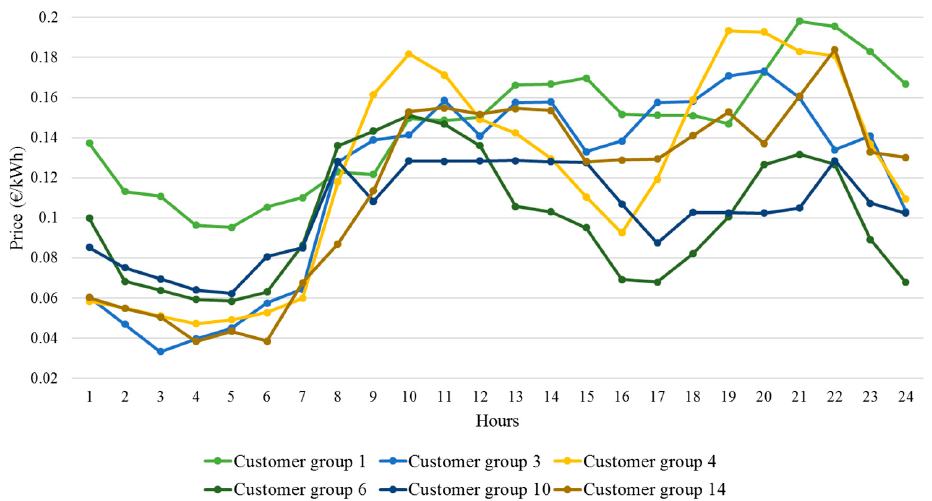
Figure 9. Retail rates for selected customers (Case 1). Table 6. Profit of the retail electricity provider (REP) in different cases ( € ).